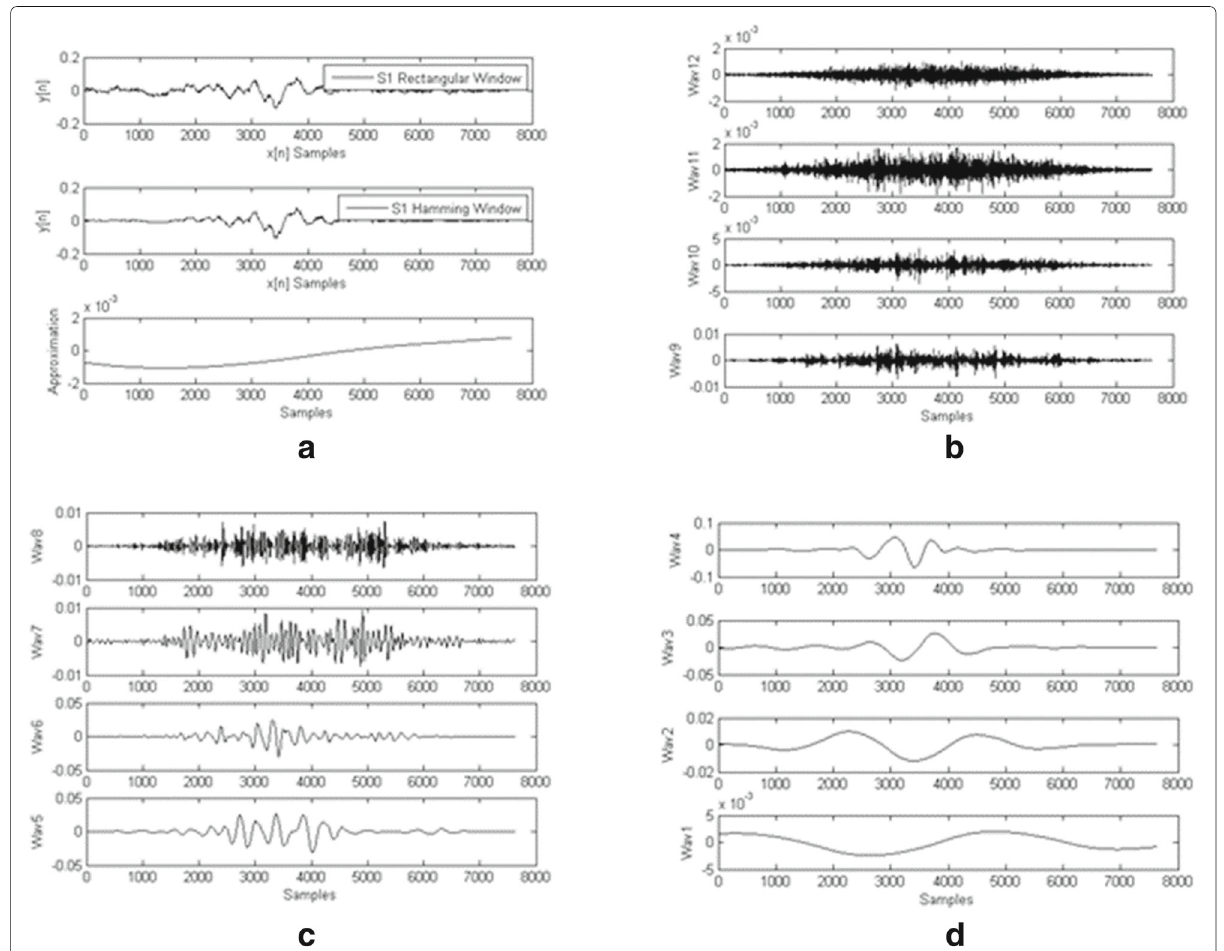
Fig. 9 Low-, mid-band, and high-frequency band extraction of S1 using wavelet transform. a S1 beat extracted using rectangular and hamming window with approximation. b S1 beat: high-frequency component extracted using wavelet transform. c S1 beat: mid-band frequency component extracted using wavelet transform. d S1 beat: low-frequency component extracted using wavelet